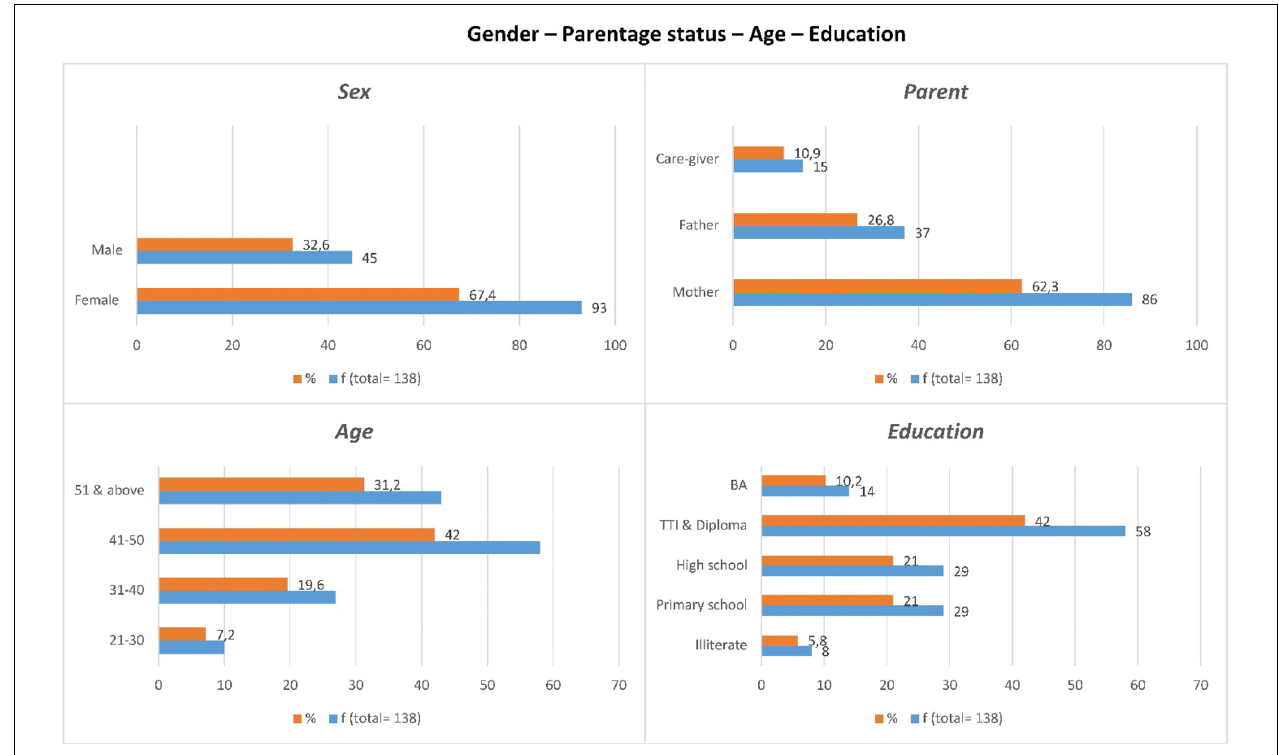
FIGURE 1 | Gender, parentage status, and education level of parents and caregivers.